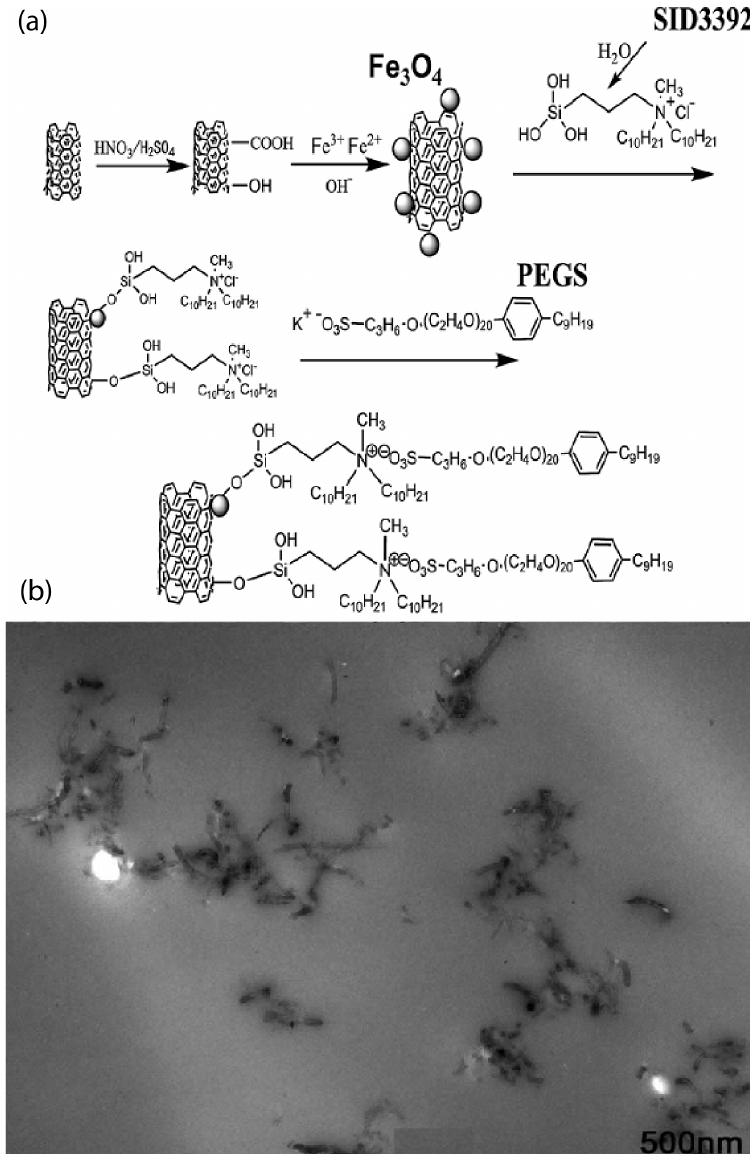
Figure 7. ( a ) MWCNT derivative, ( b ) TEM image of the liquid-like MWCNT derivative/epoxy nanocomposite. Reprinted with permission from Zheng et al.